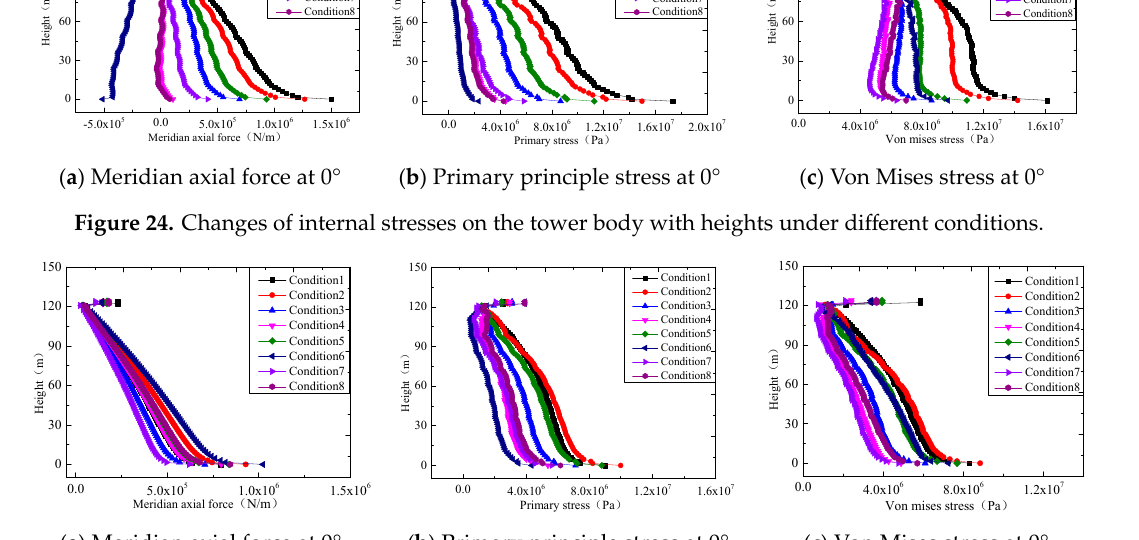
Figure 25. Changes of RMS of internal stresses on the tower body with heights under different conditions.